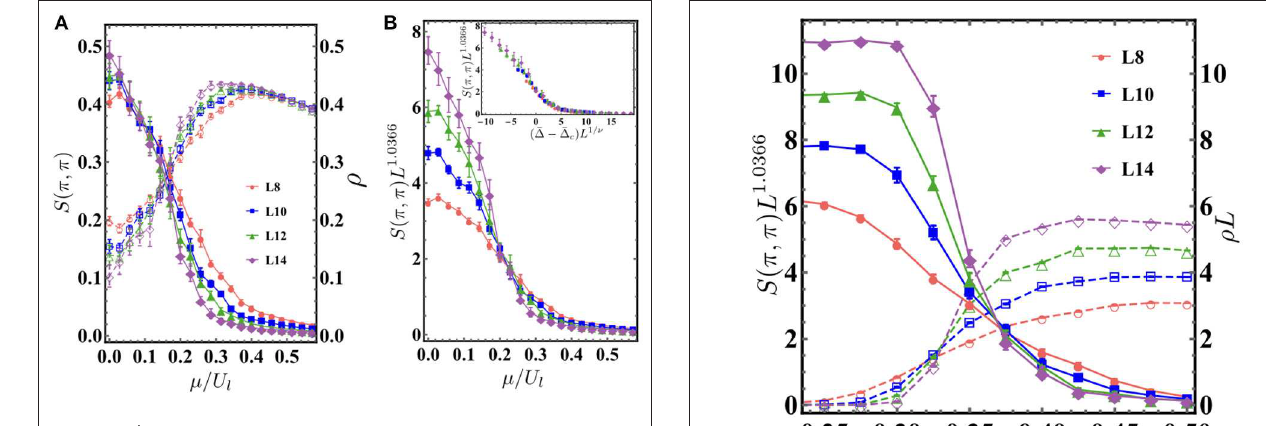
FIGURE 2 | Model 1 (cavity-mediated long-range interactions): all of the following results are at fixed disorder strength 1/ t = 2 and t / U l = 0.2857. (A) The structure factor S ( π , π ) and superfluid stiffness ρ as a function of µ/ U l for different system sizes L = 8, 10, 12, and 14 (red dots, blue rectangles, green up triangles, and purple diamonds). (B) The finite size scaling result of structure factor S ( π , π ) for above system sizes. The crossing of different curves marks a transition point at µ/ U l = 0.2 ± 0.05. Insert shows the data collapse result using ν = 0.67 and ¯ 1 c = ( t / U l ) c = 0.2 corresponding to the critical point extracted from main plot.